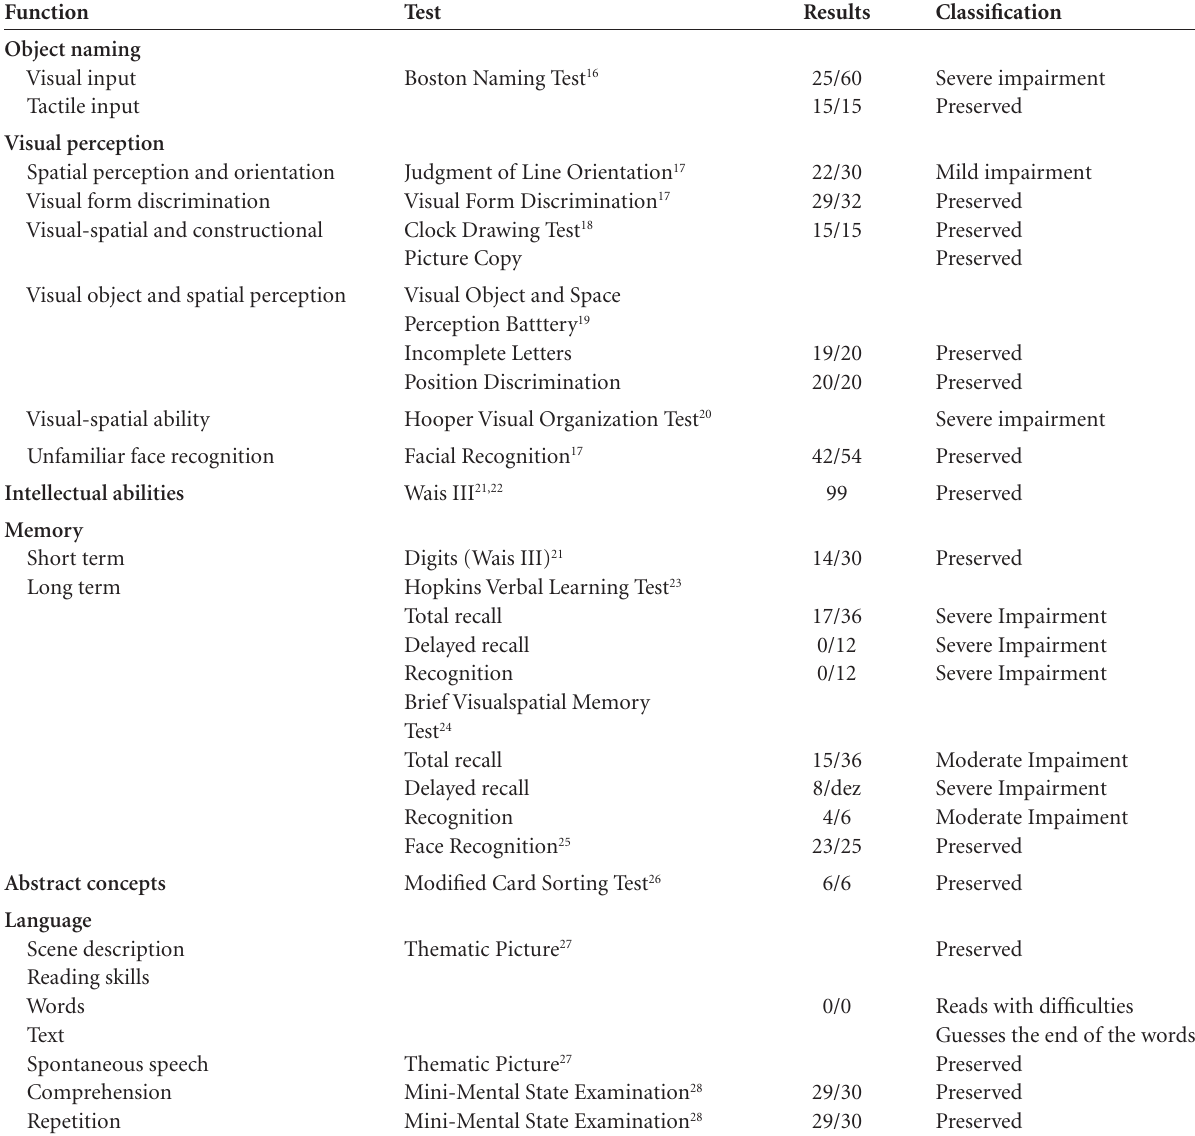
Table 1. Neuropsychological tests and